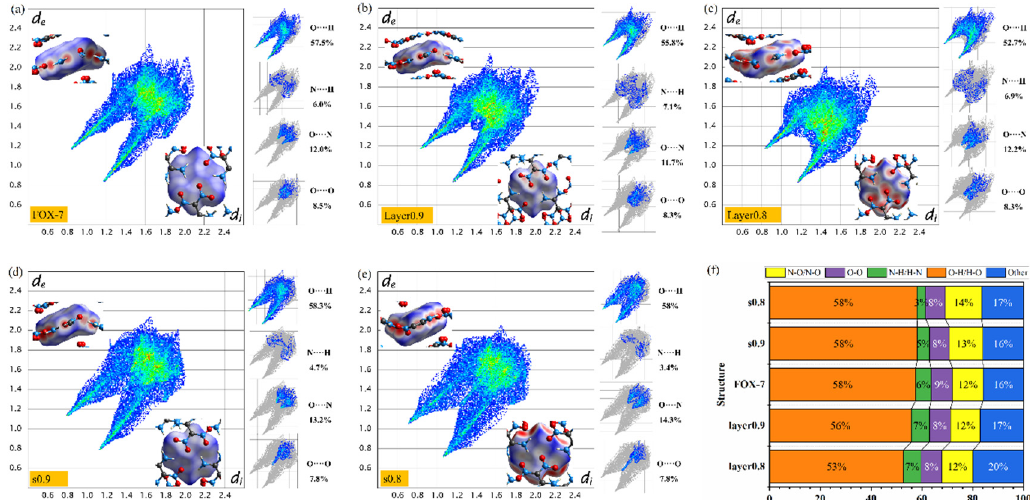
Figure 4. ( a )–( e ) The Hirshfeld surface and the related 2D fingerprint plots of five cases: FOX-7, Layer0.9, Layer0.8, s0.9, s0.8; ( f ) The composition of intermolecular interactions in the five case.